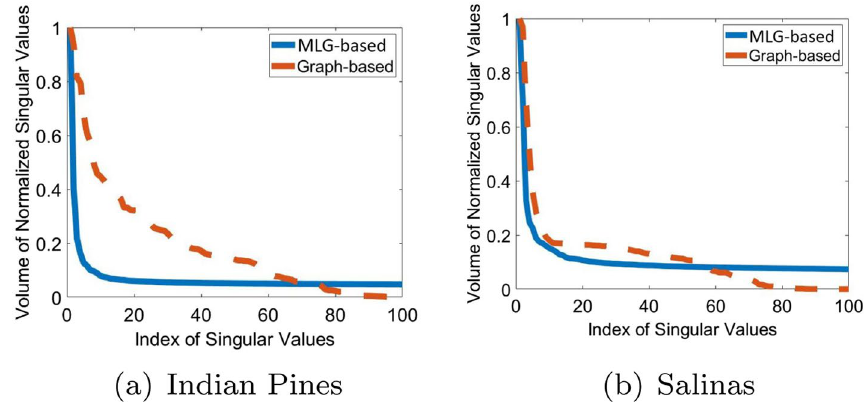
Fig. 3 Distribution of superpixel-wise singular values in HSI dataset